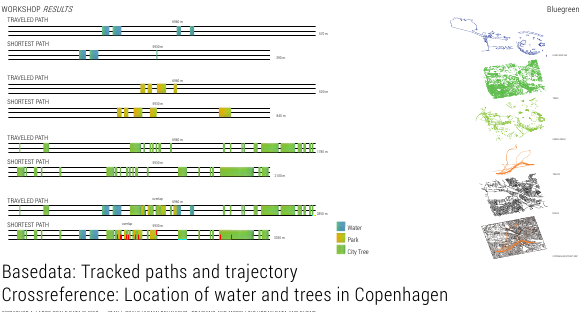
Figure 12: (top to bottom) Conceptual diagram of shortest/actual routes; scaled juxtapositions of shortest/actual routes; mapped trajectories (shortest black, actual in ochre) showing parks (yellow), waterways (blue) and street trees (green). Image: